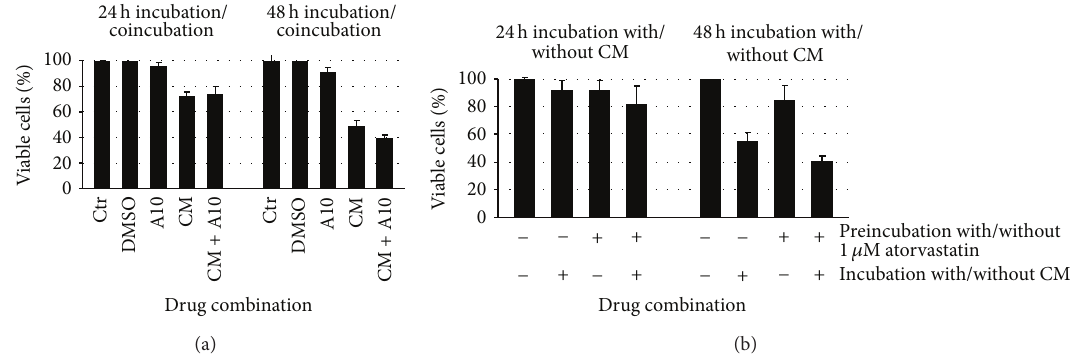
Figure 3: Antileukemic potential of atorvastatin (A) at 10 𝜇 M, cladribine + mafosfamide combination (CM), or atorvastatin in combination with cladribine + mafosfamide (CM + A) in comparison to the antileukemic potential of CM in PBMCs pretreated (or not) with atorvastatin at 1 𝜇